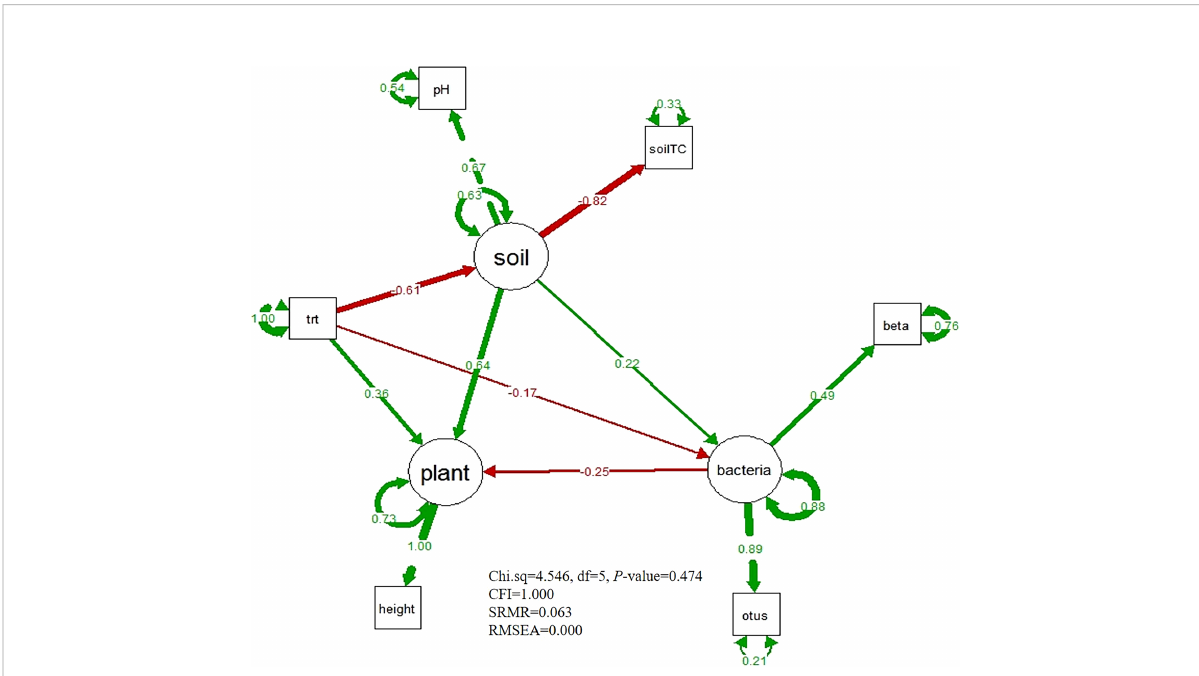
FIGURE 5 The Structural equation model of nitrogen addition treatment, soil physical and chemical property, bacterial diversity and plant height. The red arrows mean negative effect, the green arrows mean positive effect. Thicker lines denote higher effects. “ trt ” is the nitrogen addition treatment, “ SoilTC ” is soil total carbon, “ beta ” means bacterial beta diversity, “ otus ” indicates bacterial